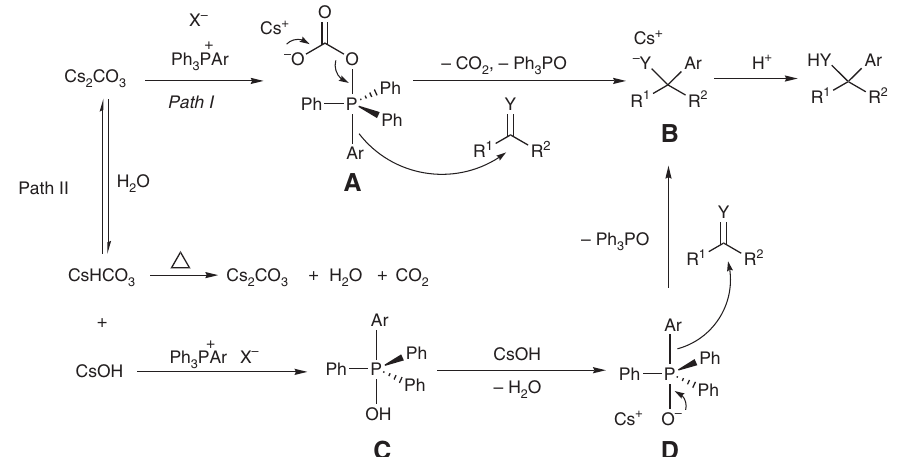
Figure 5 | Proposed nucleophilic arylation mechanism. The reaction should be predominantly initiated by Cs 2 CO 3 (path I), and may also be promoted by CsOH due to the trace amount of water present in the reaction system (path II).